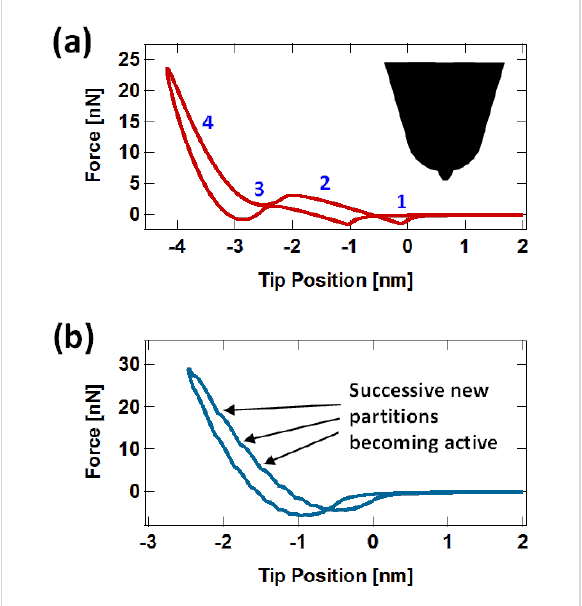
Figure 5: (a) Force curve for a 20 nm radius tip with a 2.5 nm radius protrusion at its apex as shown in the inset. The blue labels on the curve indicate the locations where, (1) the apex protrusion is approaching the surface in the attractive regime, (2) the apex protru- sion is experiencing repulsive forces, (3) the rest of the tip is approaching the surface in the attractive regime, and (4) the entire tip is experiencing repulsive forces. The retract portion of the curve is similar to the approach but shows the expected offsets in the force minima, which are a consequence of viscoelastic relaxation. (b) Oscil- lations in the force curve due to the use of too coarse a surface parti- tion. The simulation parameters are the same as for Figure 4, except for the irregular tip geometry in (a) and the coarser partition in (b) described in the